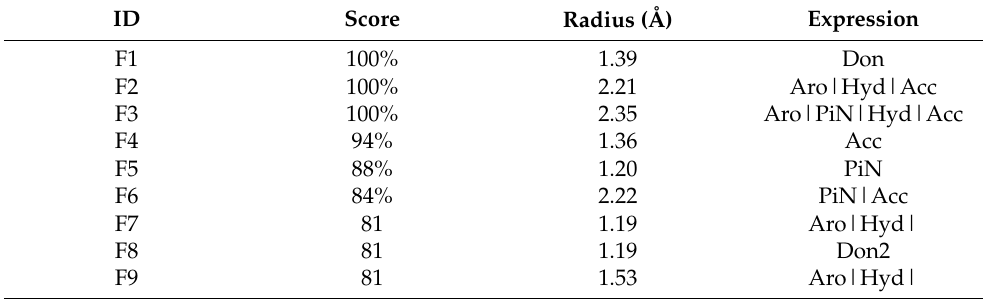
Table 3. List of the recurrent pharmacophore groups shared by 80% of the F508del-CFTR correctors herein studied, in tandem with their ID, score, radius, and expression